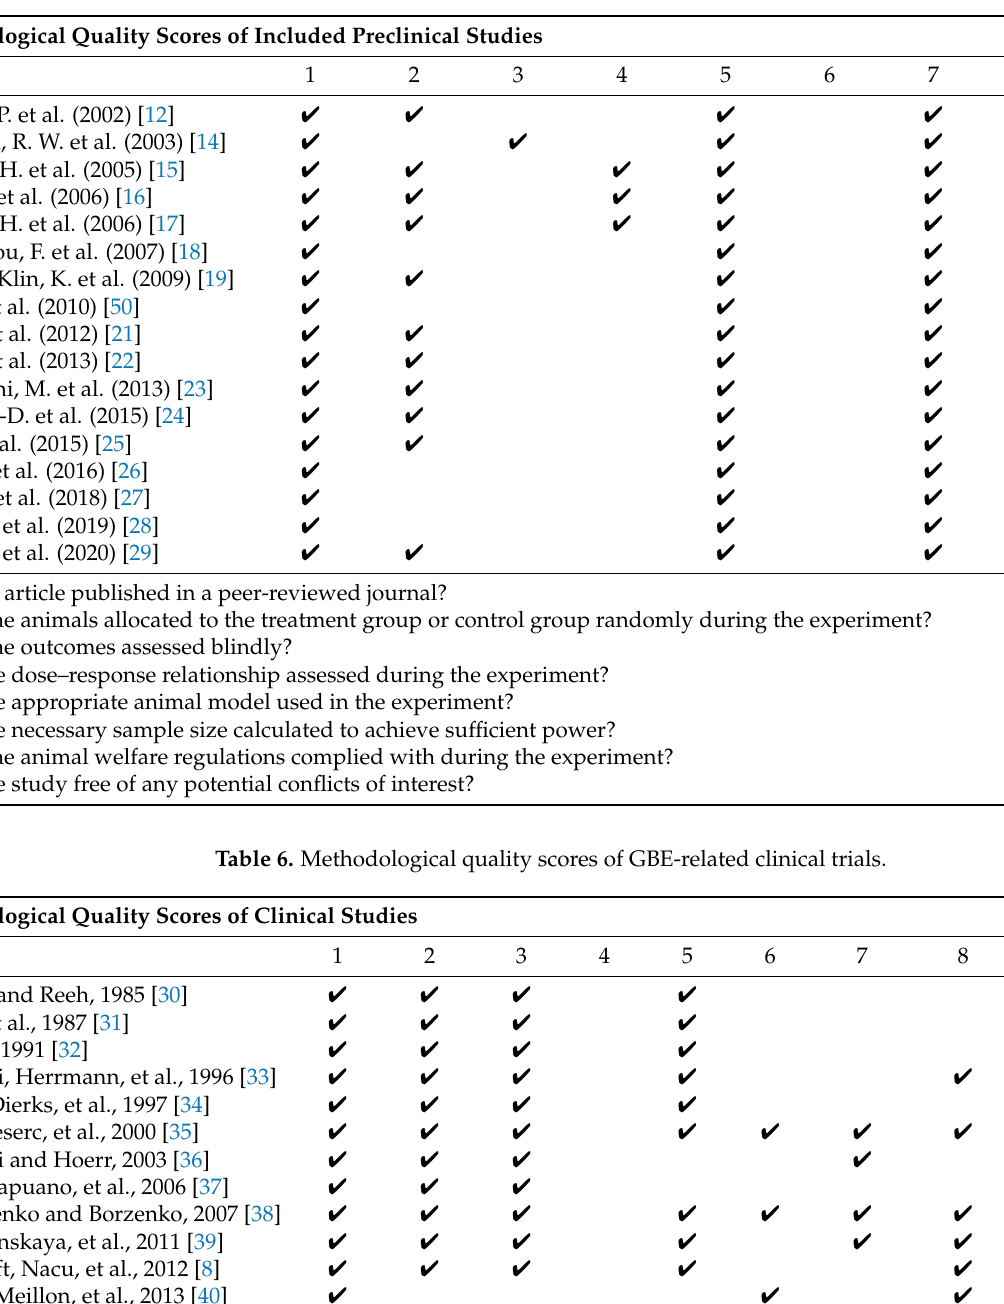
Table 5. Methodological qualities of GBE animal studies.